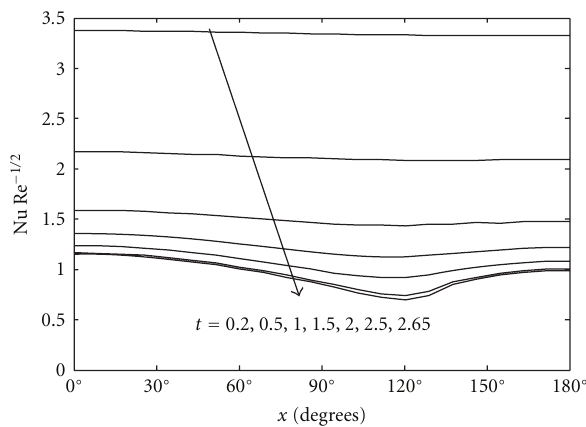
Figure 11: Variation of the Nusselt number with x for K = 2 and for various values of t when Pr = 7, α = 1 . 25 (assisting flow) and n = 0.